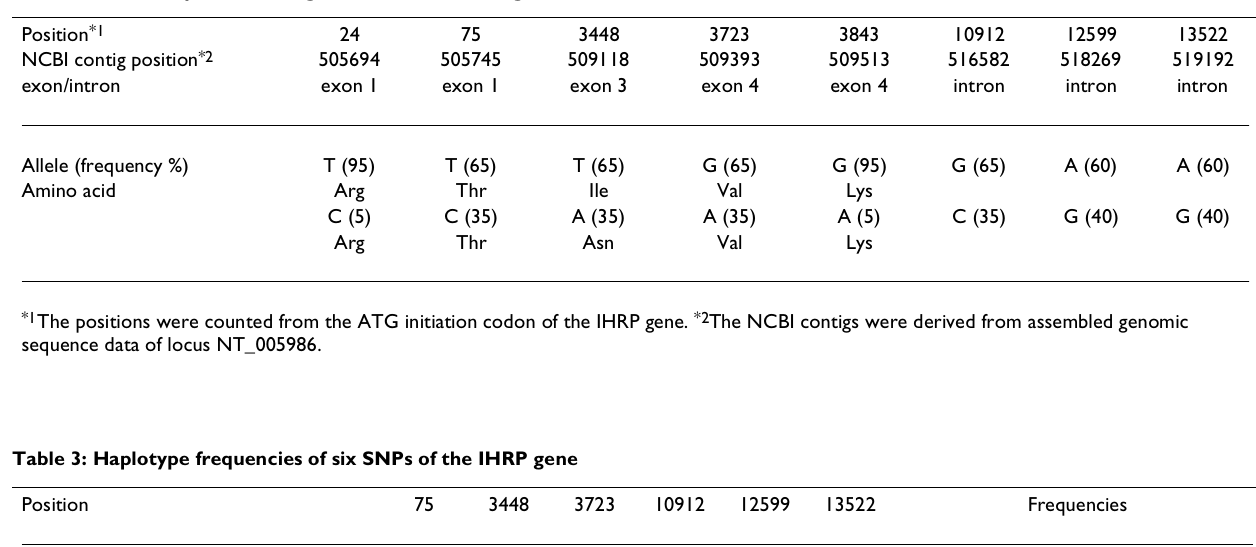
Table 2: Allele frequencies of eight SNPs of the IHRP gene Position *1